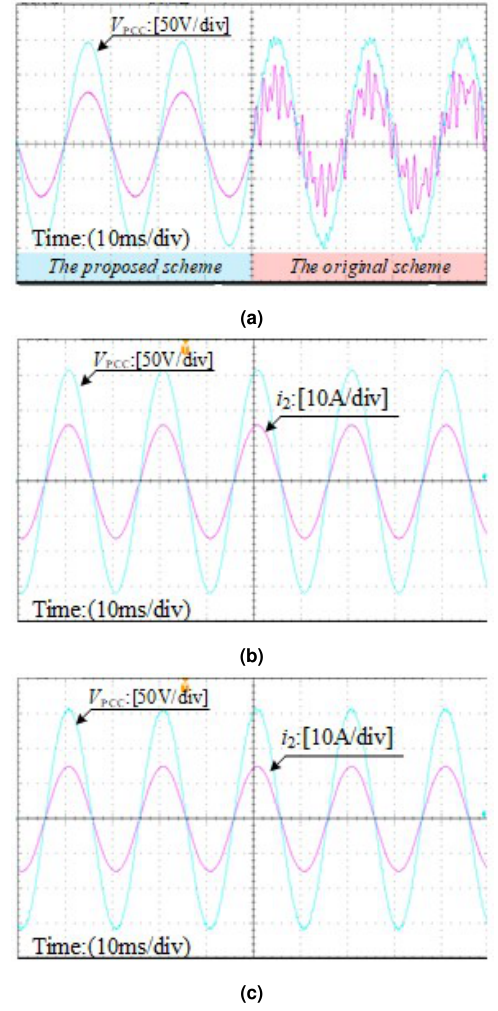
Fig. 19. Steady-state experimental waveform of improved wac control method. (a) L g = 0mH. (b) L g = 0.5mH. (c) L g =